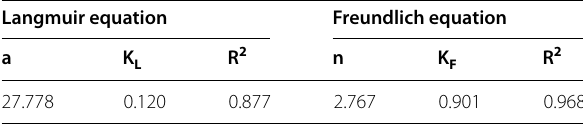
Table 2 Parameters of Langmuir and Freundlich Equations Langmuir equation